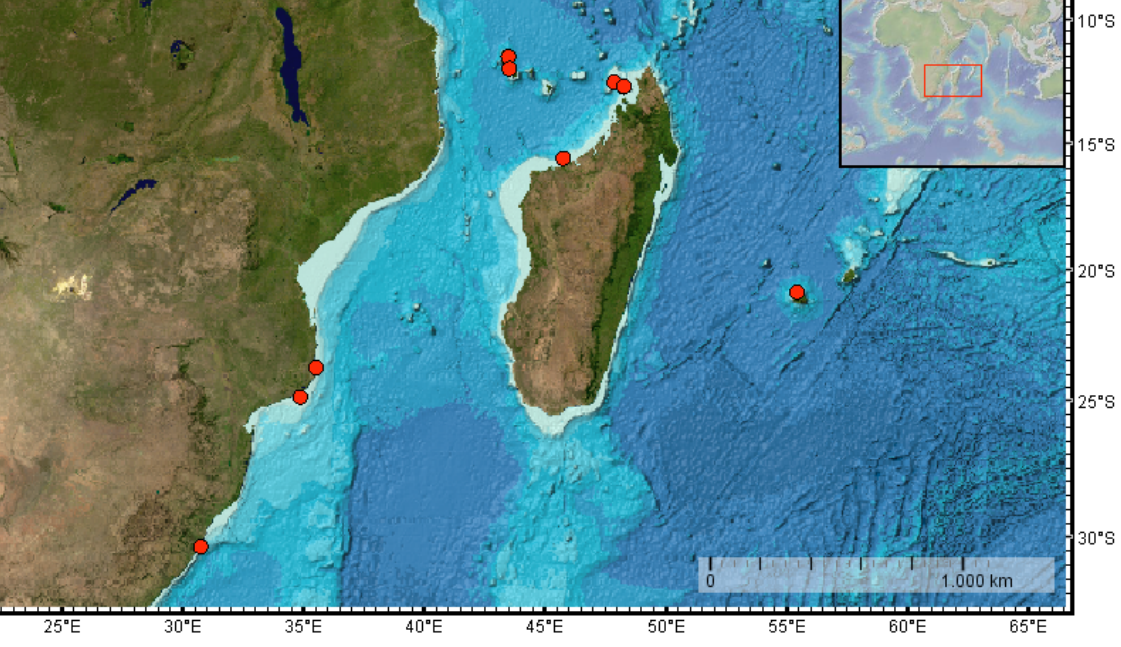
Fig. 6. Distribution map for Afonsoconus crosnieri sp. nov. red circles indicate the points where the species has been